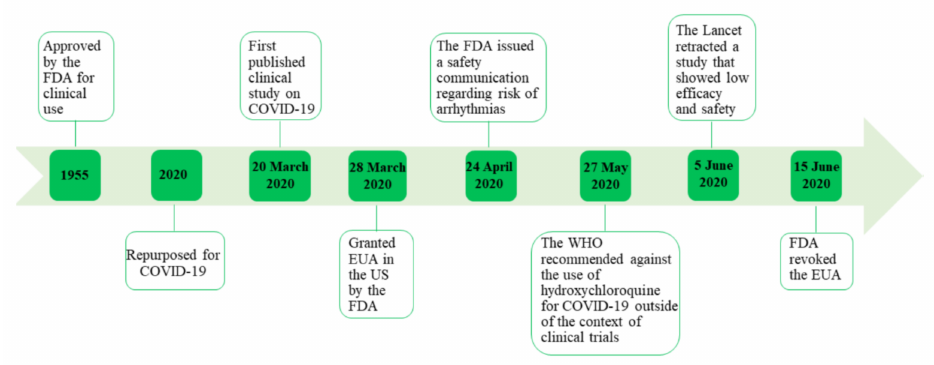
Figure 3. Timeline of hydroxychloroquine from FDA approval to repurposing for